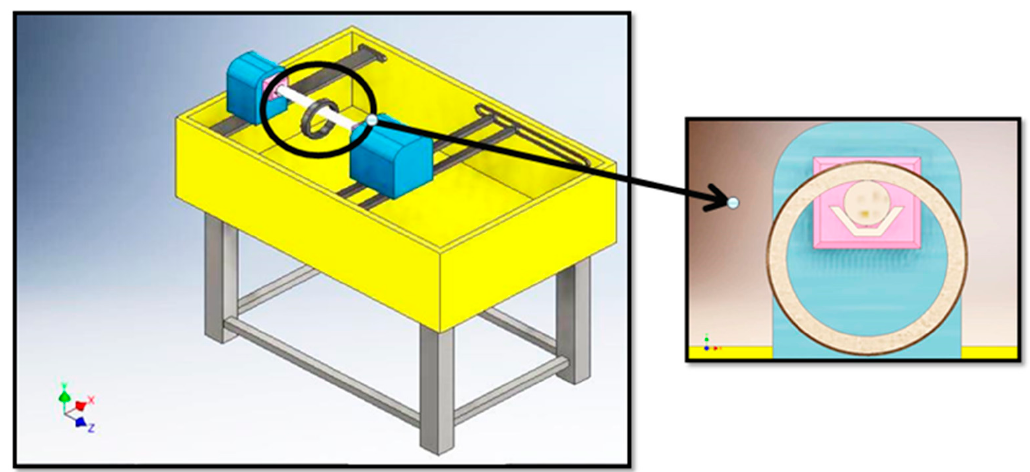
Figure 4. The cylindrical part position on the standard equipment.